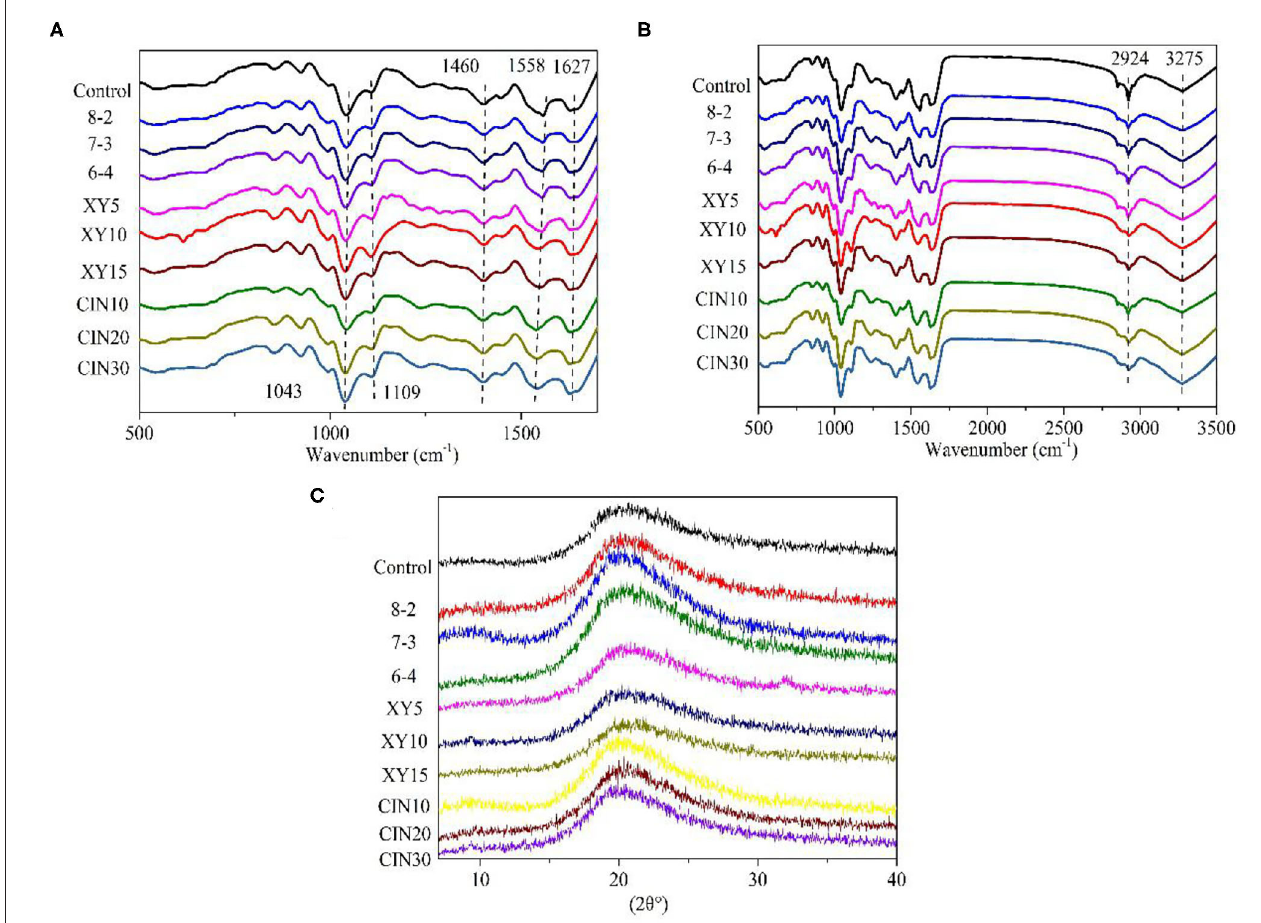
FIGURE 3 | (A,B) Attenuated total reflectance–Fourier transform infrared spectroscopy (ATR-FTIR) spectra and (C) X-ray diffraction (XRD) patterns of GP-based composite films.